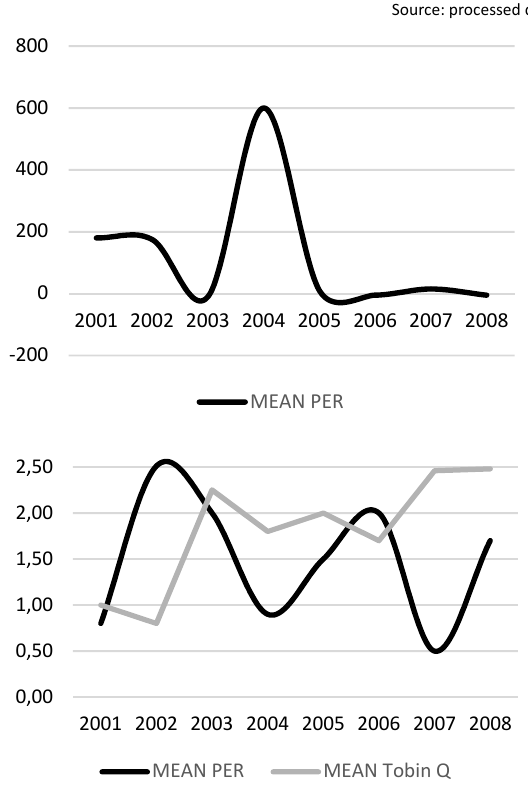
Figure 5. Development of Average. Average Value of Companies in Sector. Indicator Value in Property and Real Estate during